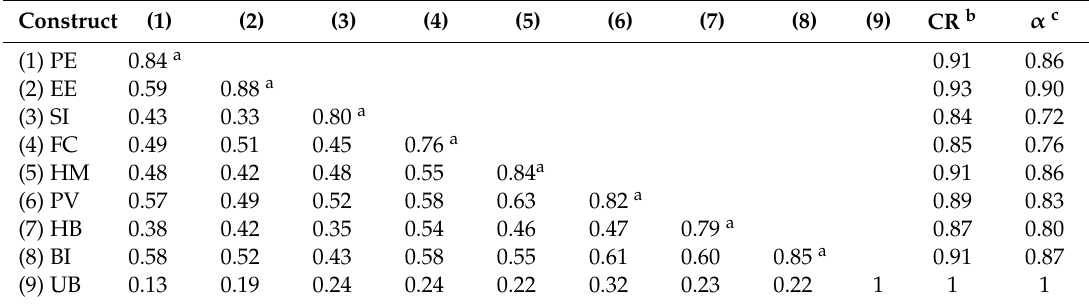
Table 2. Reliability, convergent, and discriminant validity of measurement